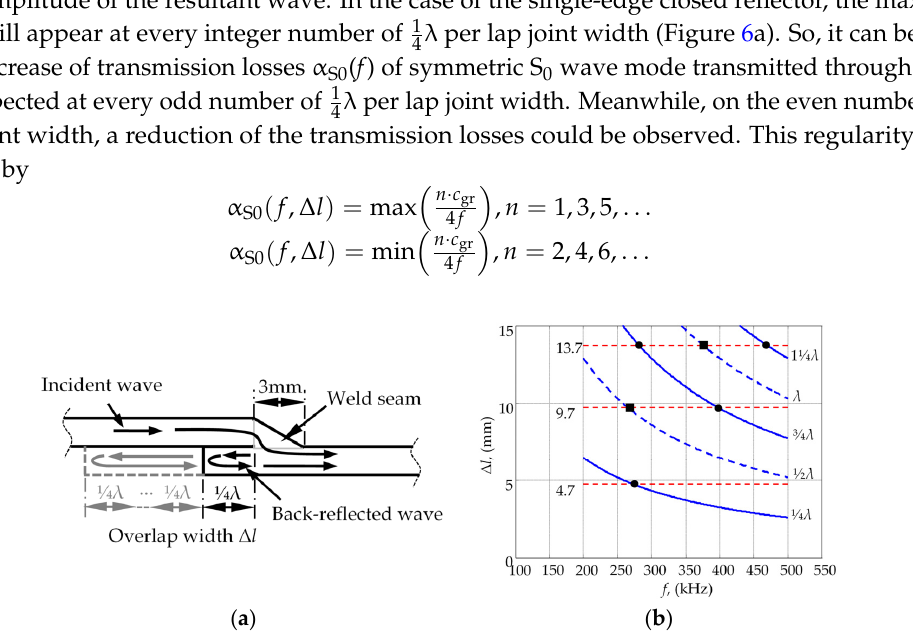
Figure 6. ( a ) Wave propagation and reflection in the lap joint connection; ( b ) dependence of the transmission losses local maxima and minima from the wavelength for particular lap joint width (square: local minima, dots: local maxima od the transmission losses).